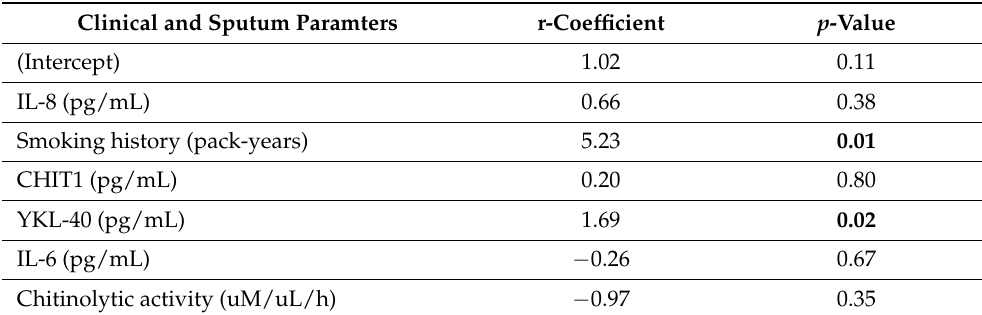
Table 3. A logistic regression model including selected clinical and sputum parameters identifying risk factors for COPD.